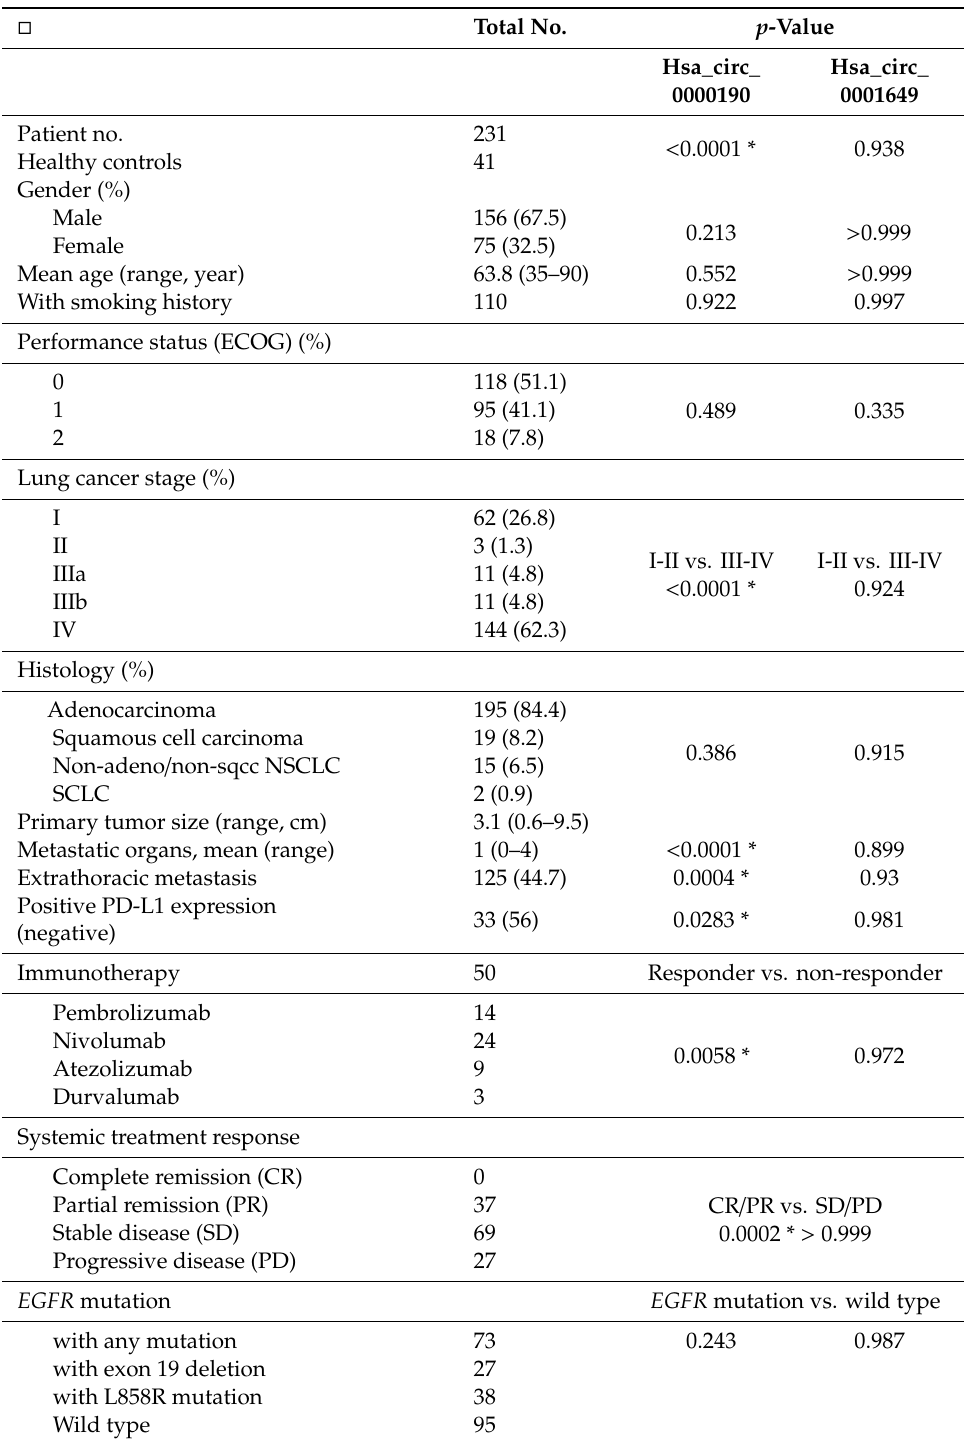
Table 1. Characteristics of